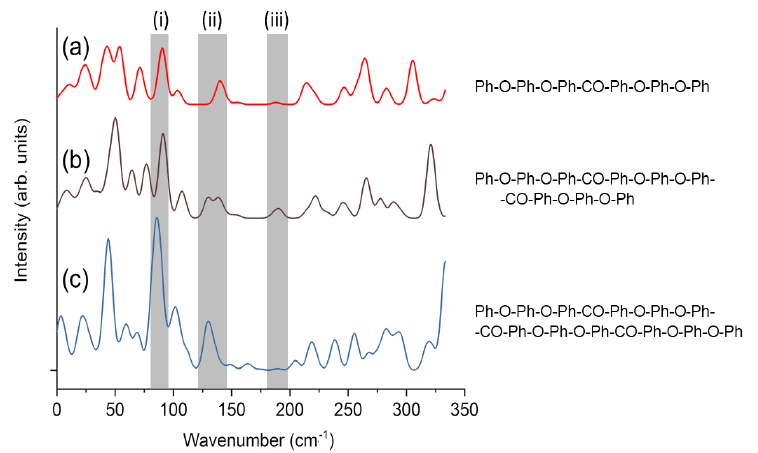
Figure 3. DFT-calculated Raman spectra of phenyl-terminated PEEK oligomers shown on the right. The peaks around 85 – 98 cm -1 , 130 – 145 cm -1 and 190 cm -1 labeled as (i), (ii), (iii), respectively. ( a – c ) represent different lengths of a PEEK molecule chain, the structures of molecules are written in the right